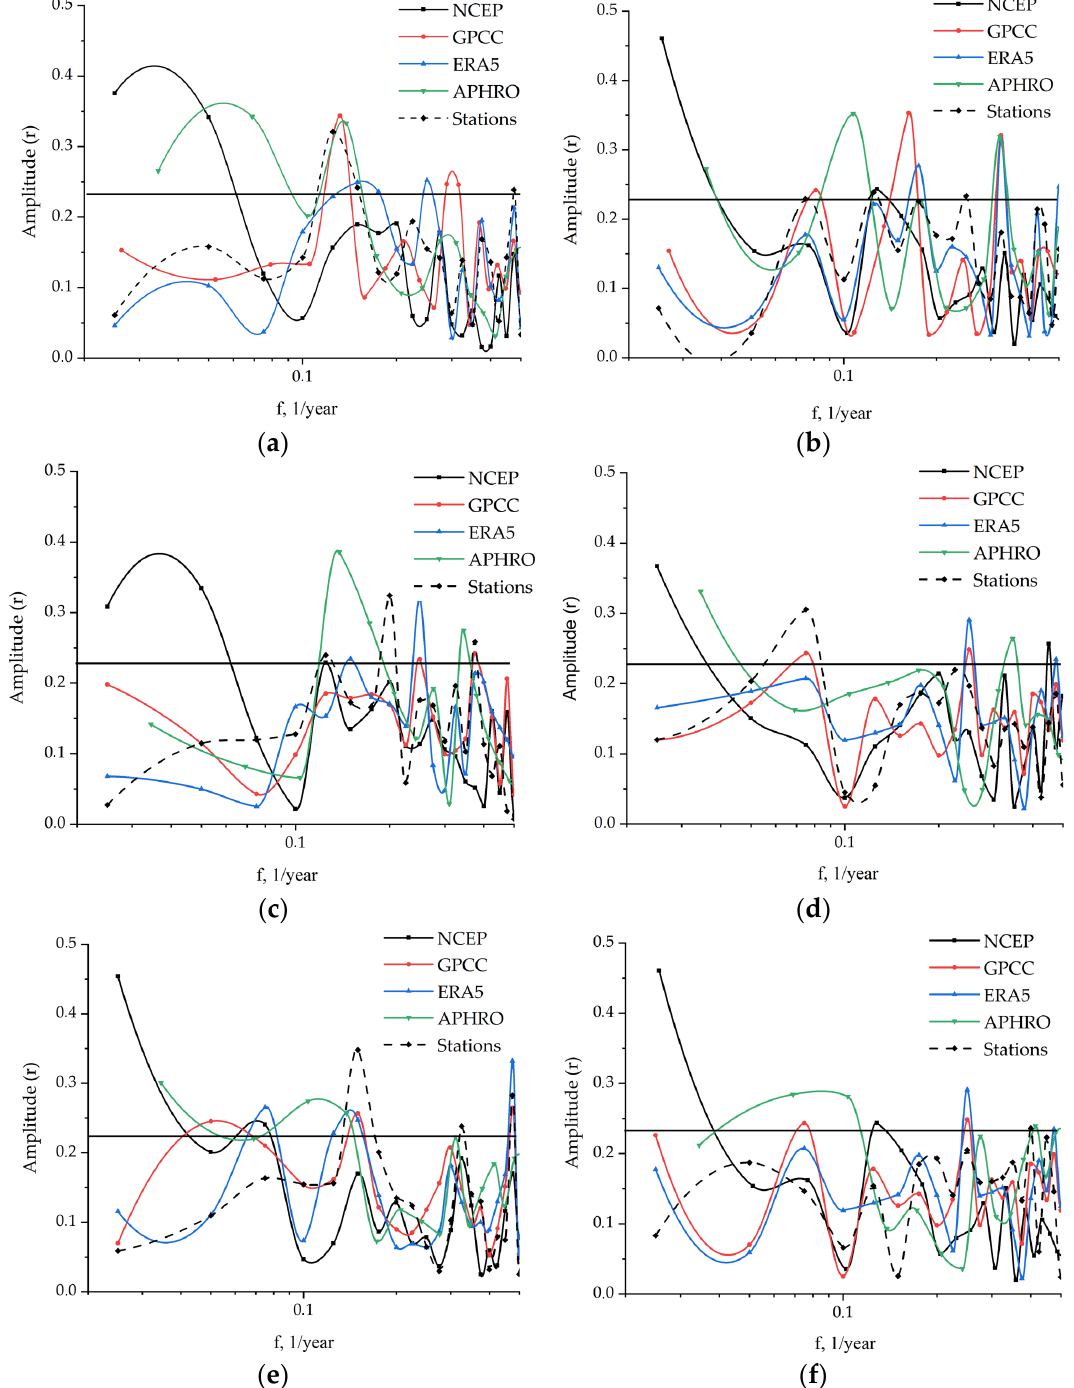
Figure 3. The Fourier amplitude spectrum of the precipitation time series: ( a , b ) median values, ( c , d ) extremely high (95%) values, and ( e , f ) extremely low (5%) values. Left panel: ( a , c , e ) warm season; right panel: ( b , d , f ) cold season. A straight horizontal line defines the significance level ( p ˂ 0.01).